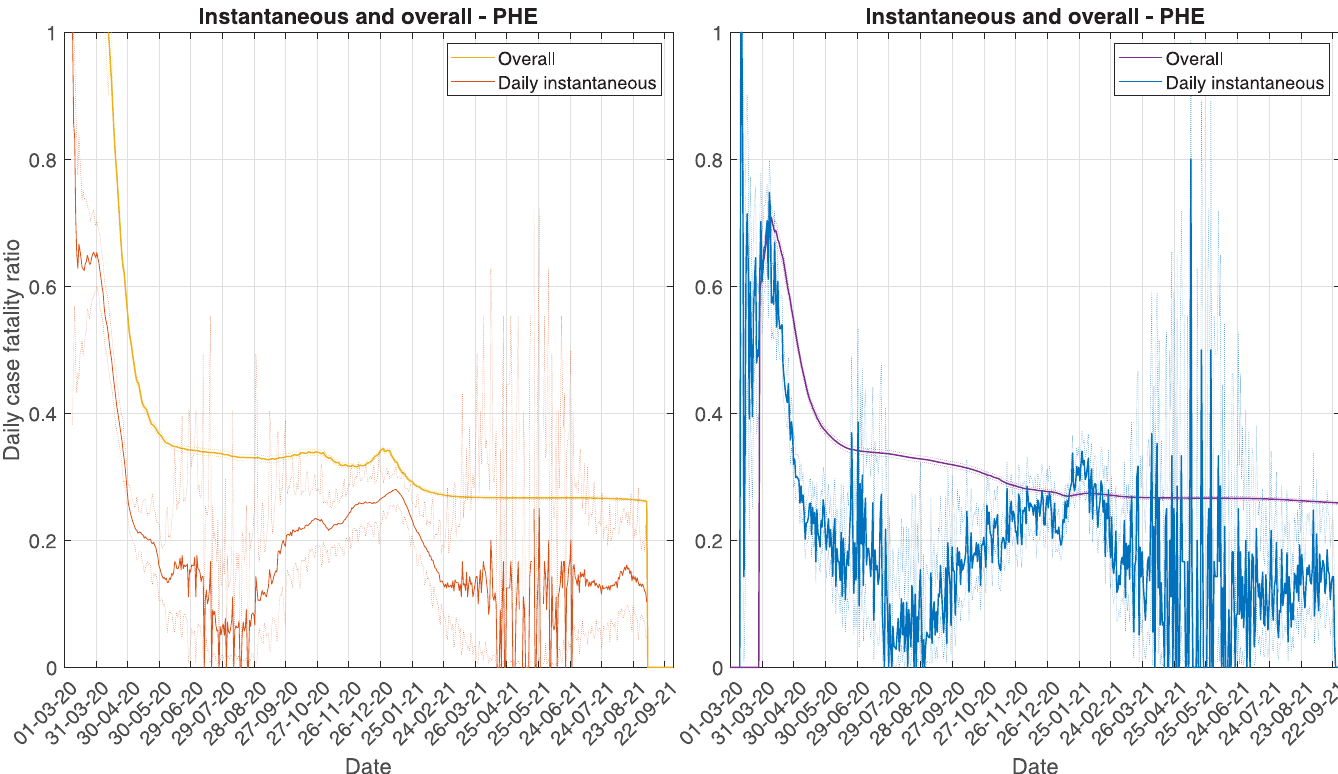
Fig 4. Comparing daily instantaneous CFR to daily overall CFR, using PHE data. The left panel shows the forward methods, and the right panel shows the backward methods.